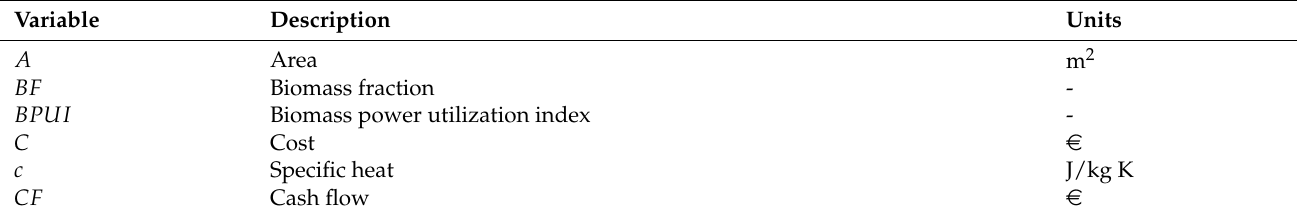
Table A1. Variables and